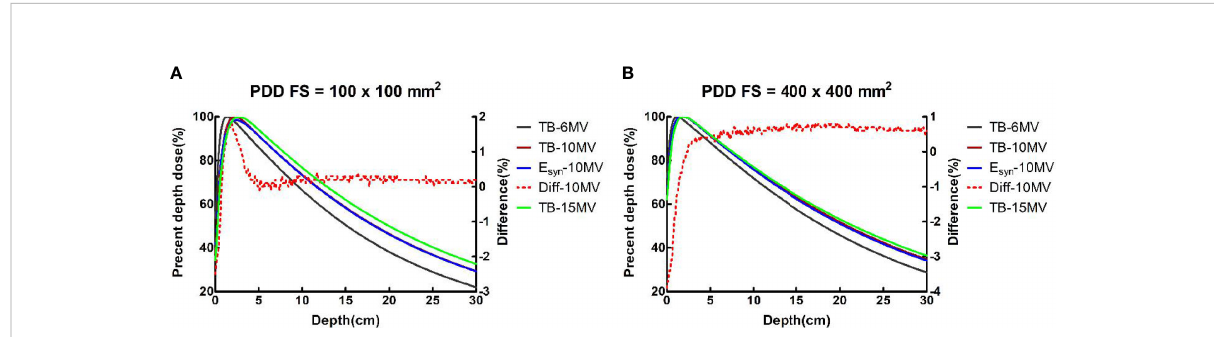
FIGURE 2 TB-6MV, TB-10MV, E syn -10MV and TB-15MV PDDs and differences between TB-10MV and E syn -10MV for the (A) 100 × 100 mm 2 and (B) 400 × 400 mm 2 fi eld